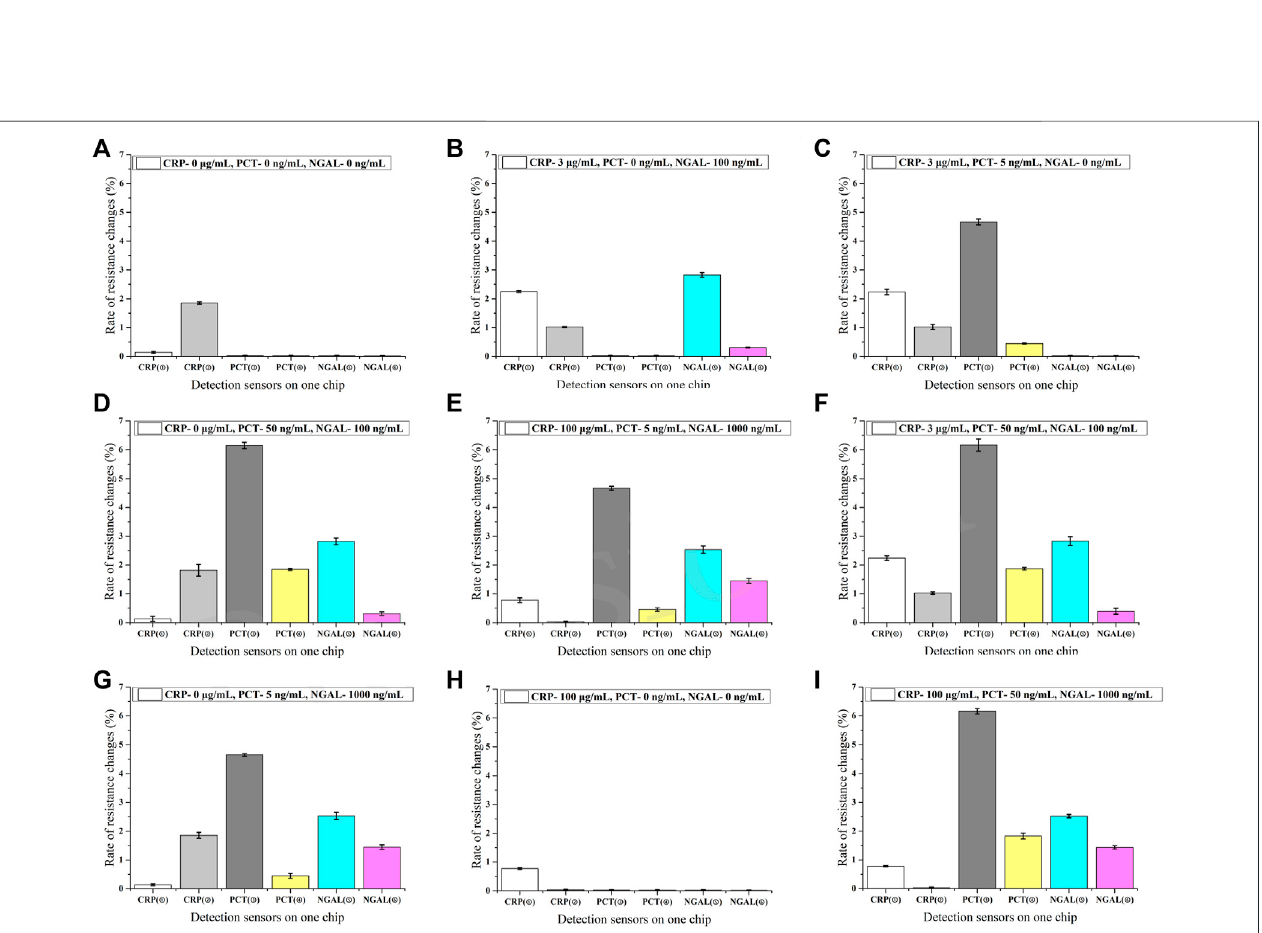
FIGURE 3 | Principle of data processing. (A) Standard curves and indicator curves of CRP obtained with external standards from sensor ① and ② . (B) Standard curves of PCT (sensor ③ and ④ ) or NGAL (sensor ⑤ and ⑥ ) obtained with external standards.